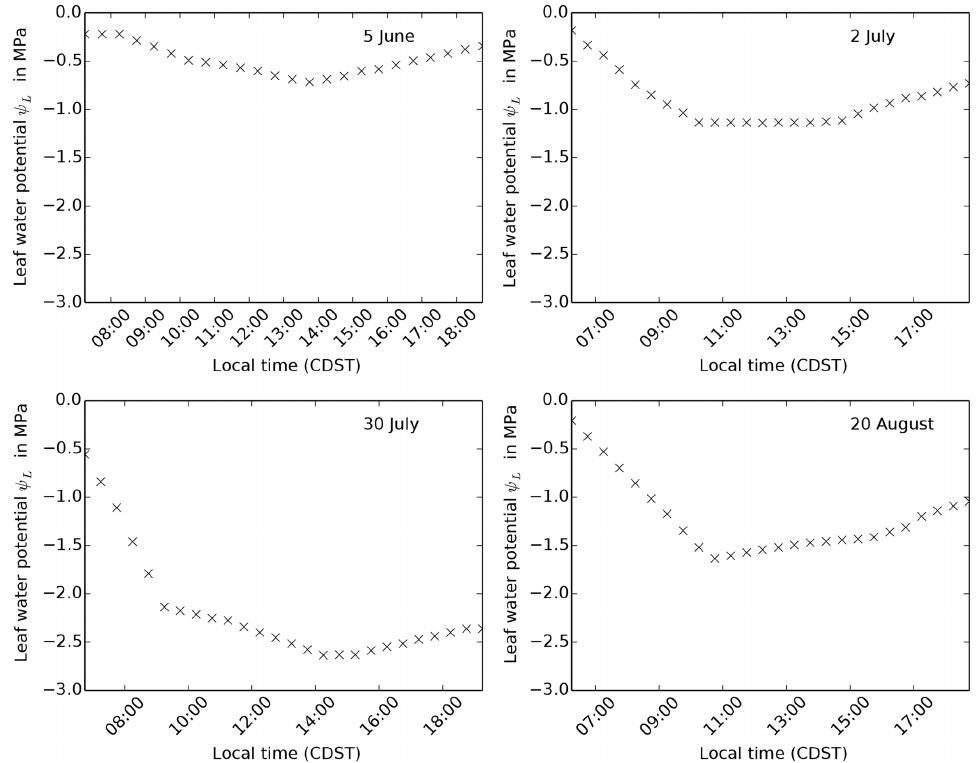
Figure 8. Leaf water potential observations for 4 days taken at FIFE site 4439 in 1987, published in Kim and Verma (1991a).